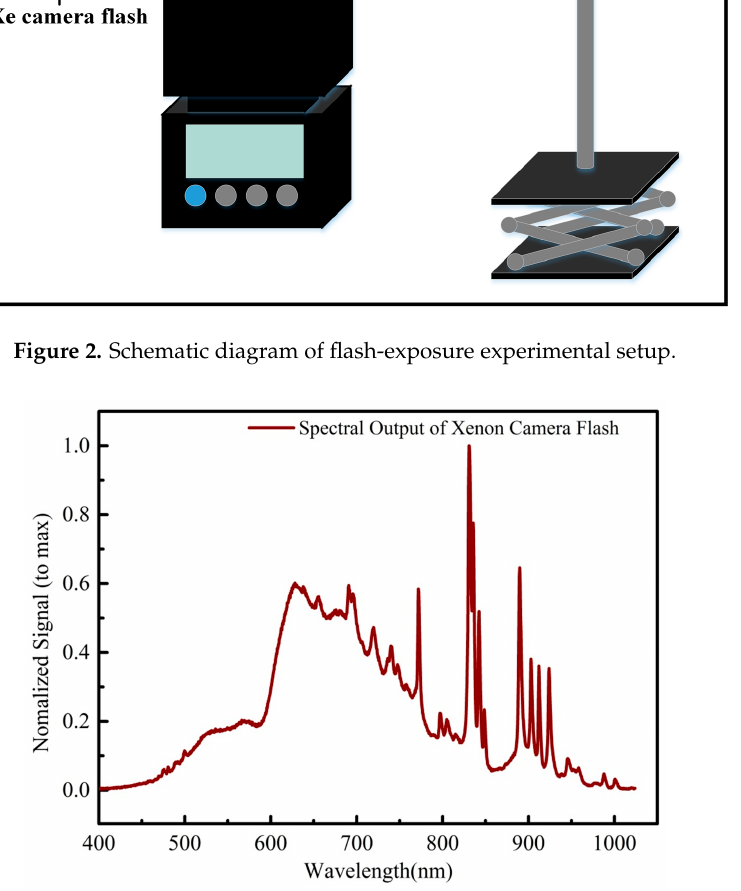
Figure 3. The emission spectrum for the conventional xenon photoflash.